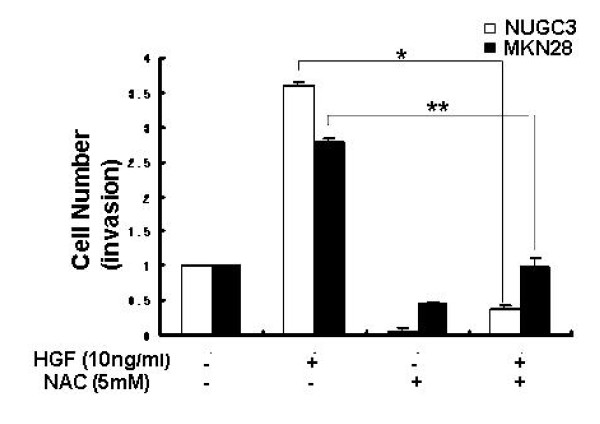
Effects of NAC on in vitro invasiveness. Cells in RPMI 1640 media supplemented with 5% FBS were placed in the upper chamber of Matrigel chamber and treated with or without NAC. The bottom chamber was filled with media containing 5% FBS and HGF with or without NAC. After 48 h of incubation, the cells which migrated through the filter were counted under light microscopy (10 fields at 200× power). Values are the means ± SD of triplicates of three independent experiments. Statistical significance was estimated by Student's t-test (*, P < 0.05; **, p < 0.01).